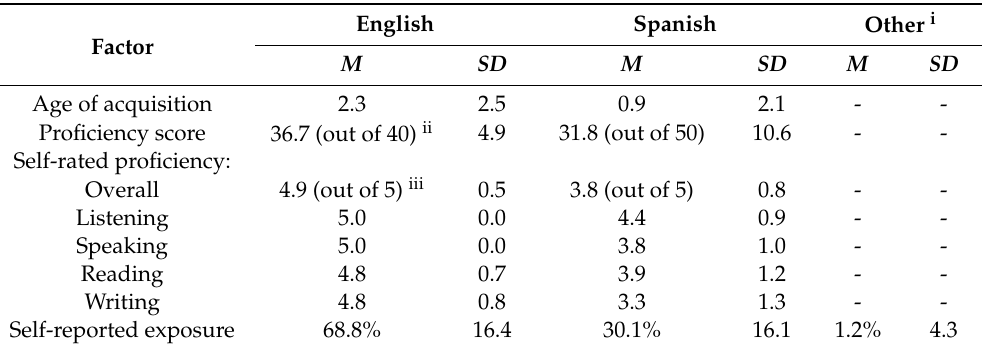
Table 1. Overview of participants’ language